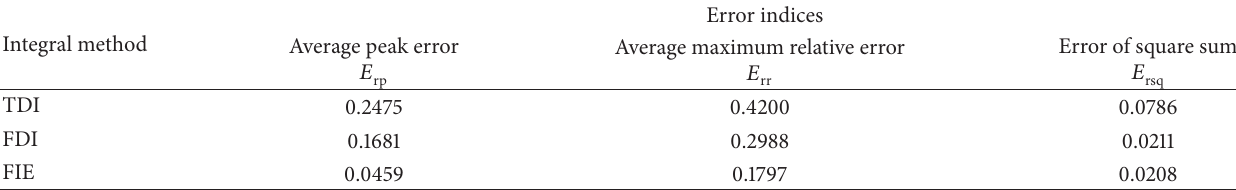
Table 1: Error comparison of integral velocity.